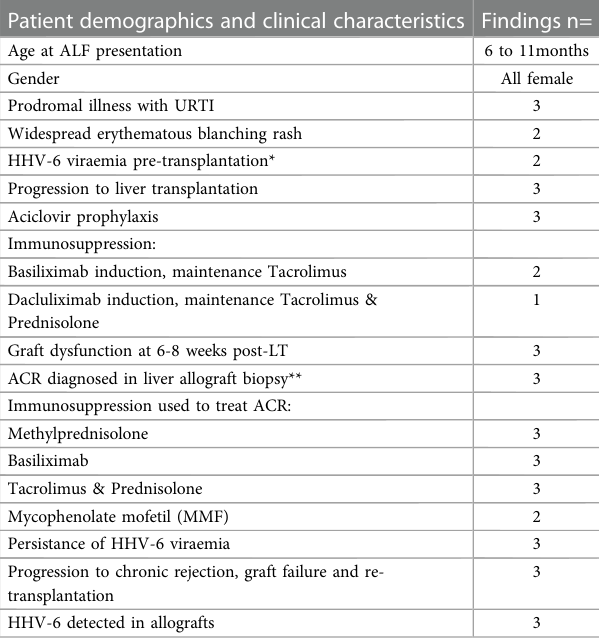
TABLE 1 Patient characteristics and clinical